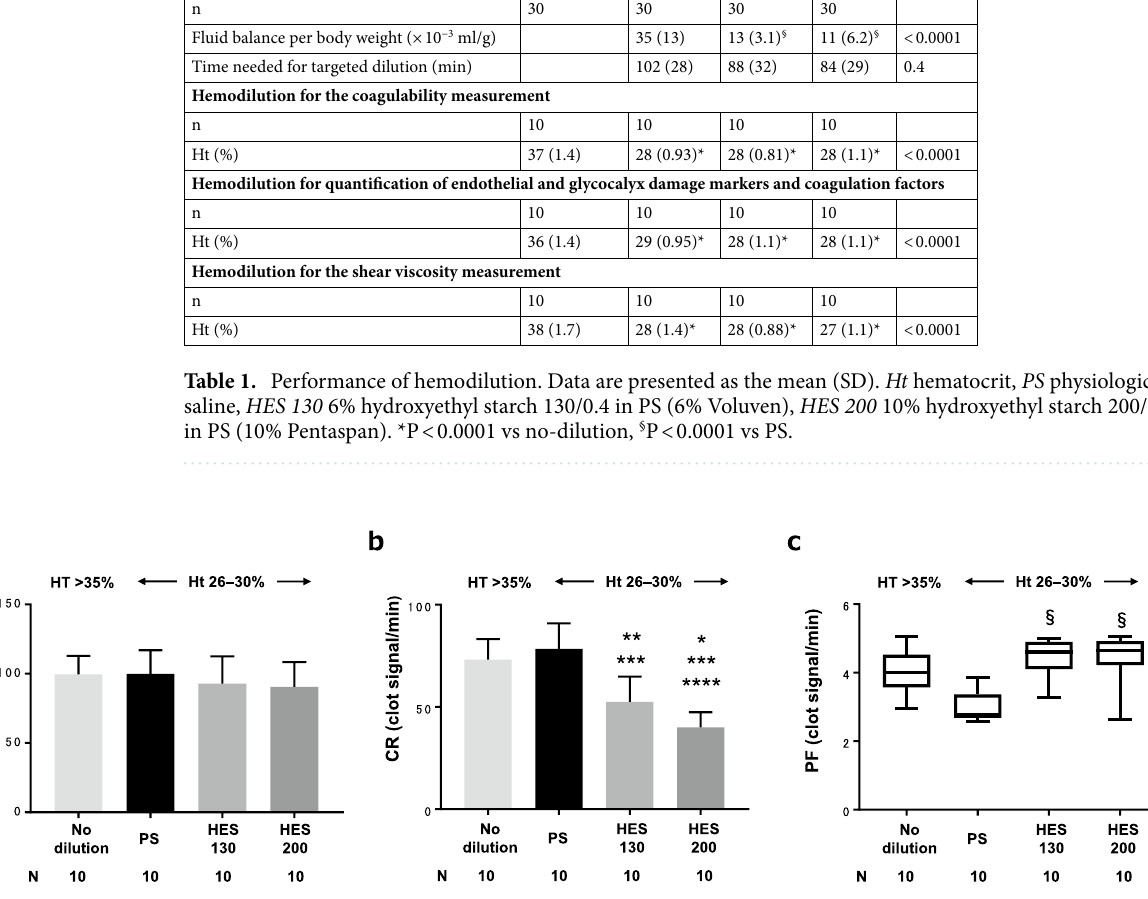
Figure 3. Coagulability measurement using Sonoclot. ACT activated clotting time, CR clot rate, PF platelet function. PS, physiological saline; HES 130, 6% hydroxyethyl starch 130/0.4 in PS (6% Voluven); HES 200, 10% hydroxyethyl starch 200/0.5 in PS (10% Pentaspan); Ht, hematocrit. *P < 0.0001 vs no-dilution, **P = 0.0007 vs no-dilution, ***P < 0.0001 vs PS, ****P = 0.047 vs HES130, § P = 0.002 vs